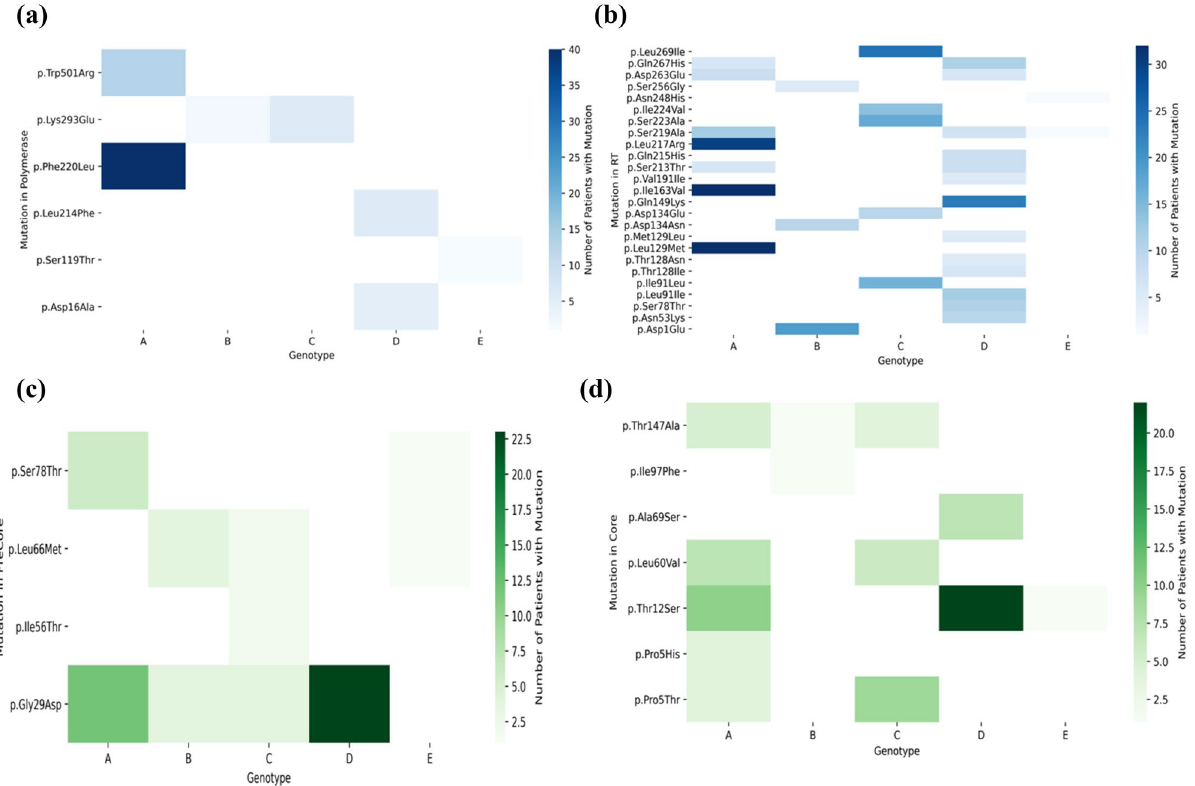
Figure 4. Heatmap of mutation hotspots for gene P in genotypes A-E: ( a ) HBV polymerase, and ( b ) HBV reverse transcriptase (RT) and heatmap of mutation hotspots for gene C in genotypes A-E: ( c ) HBV precore, and ( d ) HBV core. The white regions represent counts of mutations that are null, while dark blue (in a and b ) or dark green (in c or d ) indicates the largest number of